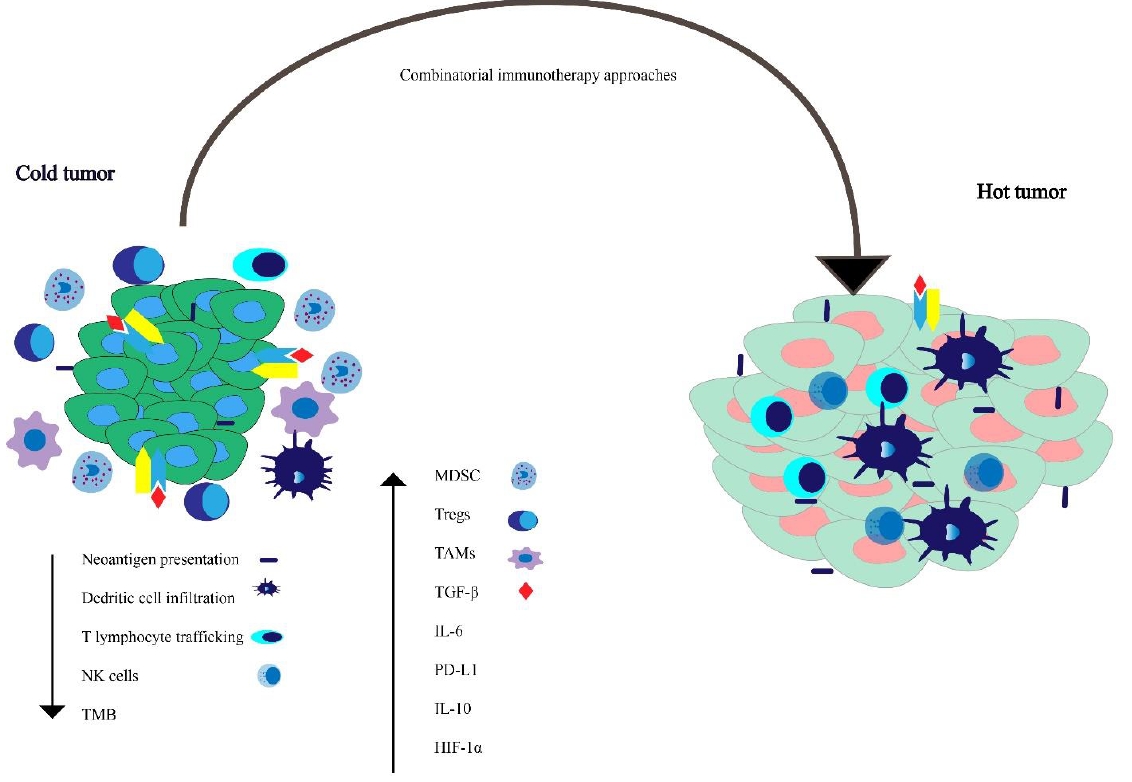
Figure 2. Working model for understanding factors influencing tumor microenvironment in tumors lacking immunological anti-tumor activity—the so-called “cold tumors”—versus tumors with immunological activity against the tumor—“hot tumors.” Combinatorial immunotherapeutic approaches can possibly convert an immunologically cold tumor to a hot tumor.